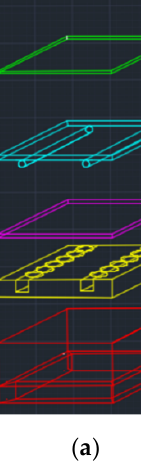
Figure 1. ( a ) CAD Design of the platform; ( b ) Harvesting floor prototype.